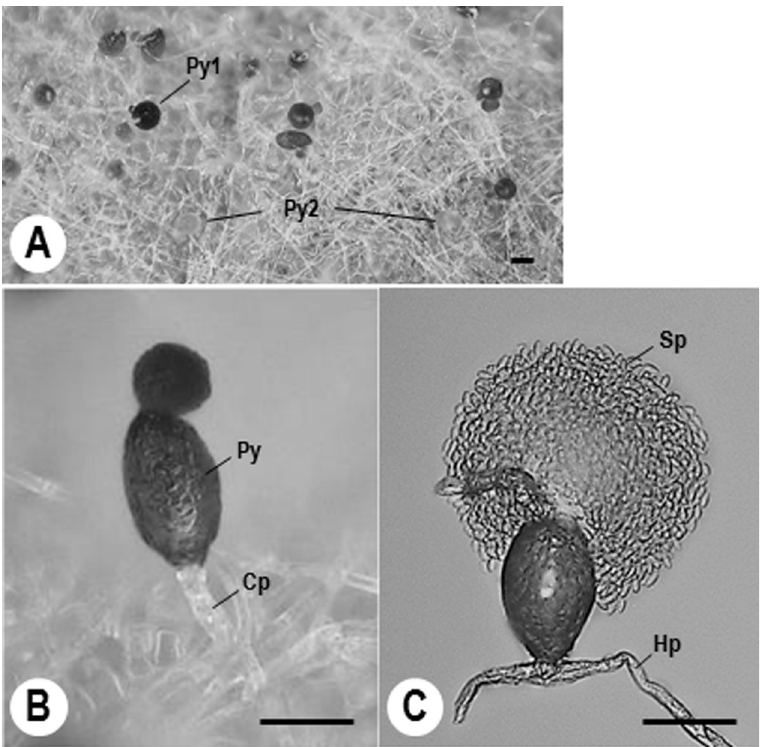
Fig 2. Digital (A and B) and light micrographs (C) of Ampelomyces strain Xs-q on tomato powdery mildew KTP-03 mycelia. A, mature (Py1) and immature pycnidia (Py2) formed onto KTP-03 mycelia. B, Pycnidium (Py) produced in KTP-03 conidiophores (Cp). C, Spores (Sp) appeared from a pycnidium after adding a drop of distilled water (10 μ L). Micrographs were taken at 14 days after spray inoculation of spores onto 10-day-old KTP-03 mycelia. Bars represent 50 μ m (A) and 30 μ m (B and C). Hp, Hypha of tomato powdery mildew KTP-03.